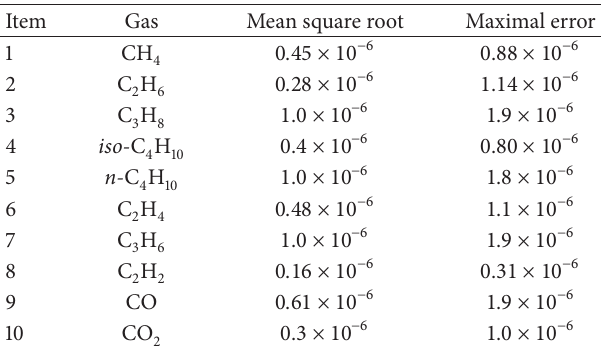
Table 3: Mean square root of the analyte and maximal analysis error in case of background